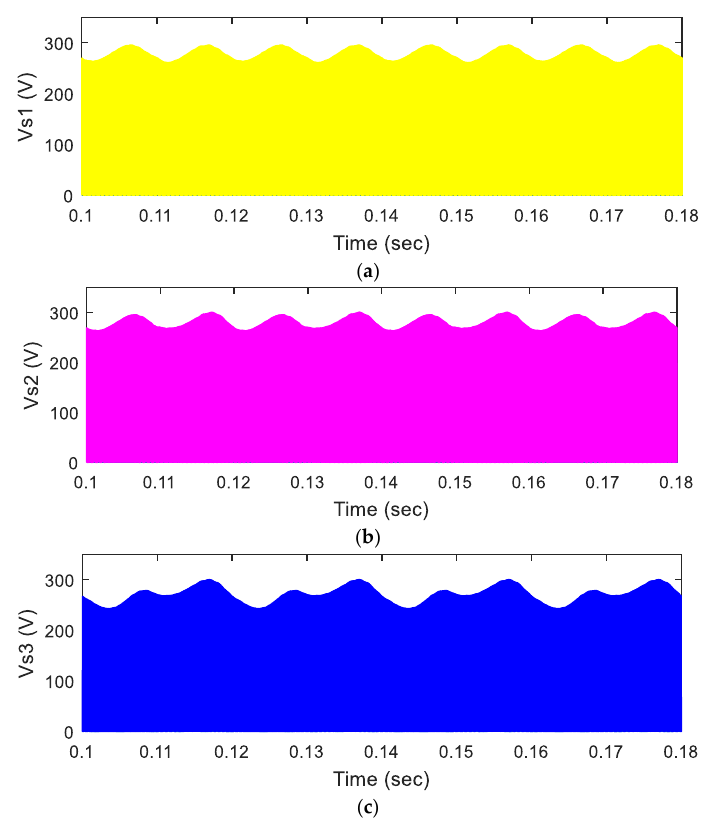
Figure 6. Input voltage at 90 V and load at 10 Ω for CUK -based ZSI. Voltage wave of ( a ) Switch S1; ( b ) Switch S2; ( c ) Switch S3.